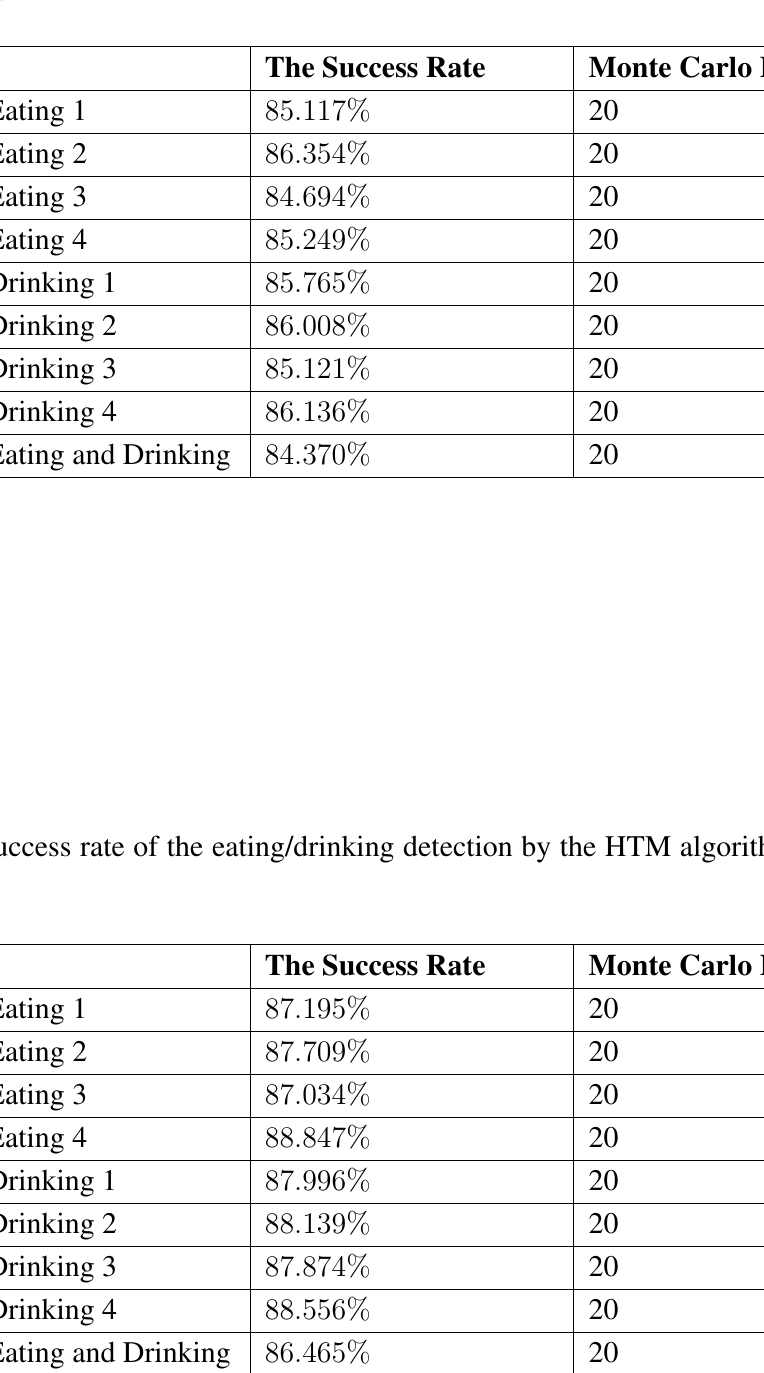
Table 3. The success rate of the eating/drinking detection by the HTM algorithm based on raw sensor data.